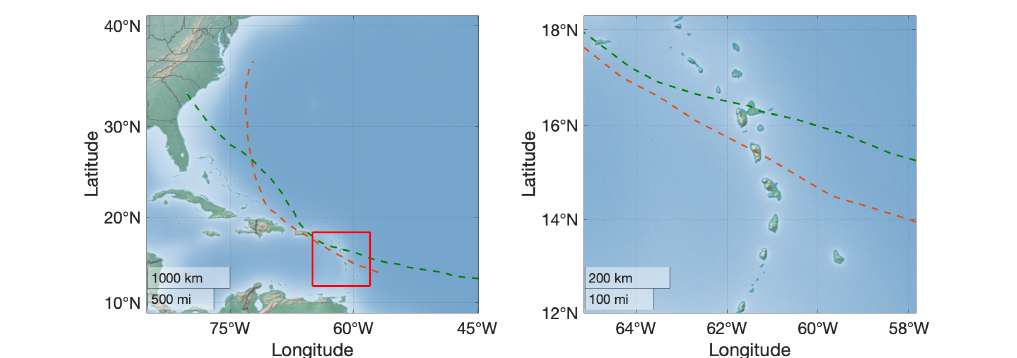
Figure 1. Regional setting. Left panel: full domain. The red rectangle indicates the region where the diagnostic of the STM-E approach is performed. The orange and green tracks respectively represent those of the Maria (2017) and Hugo (1989) cyclones (data extracted from Landsea and Franklin (2013) with cyclone status “Hurricane”). Right panel: enlarged view of the diagnostic region.